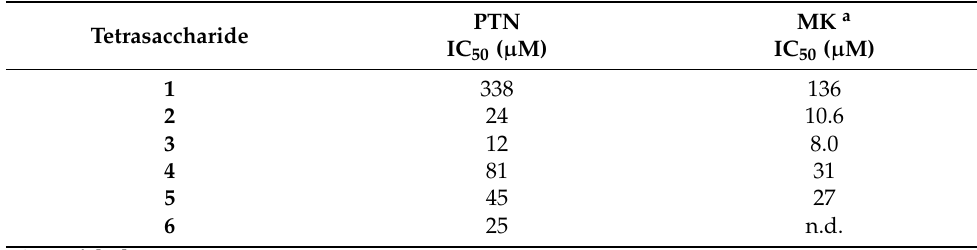
Table 1. IC 50 values for the interaction between PTN and MK with synthetic tetrasaccharides 1 – 6 by FP.